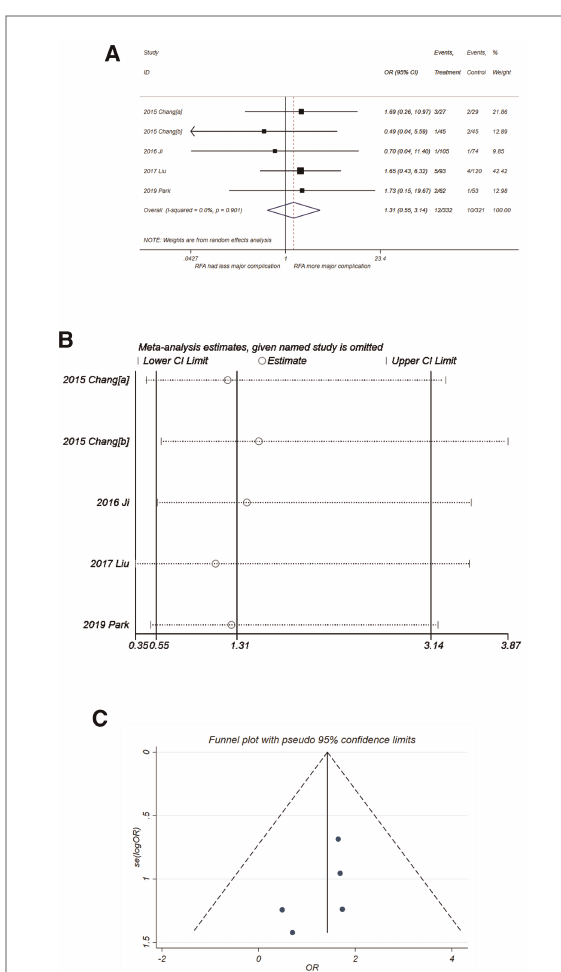
FIGURE 7 Comparison of major complication of RFA vs. PN. ( A ) The forest plot shows the OR of major complication of RFA vs. PN. OR>1 indicates that RFA has higher probability of major complication. ( B ) Sensitivity analysis was performed by omitting one study at each analysis. The result of each analysis is also presented as the forest plot. ( C ) The funnel plot was used to detect publication bias. PN, partial nephrectomy; RFA, radiofrequency ablation; OR, odds ratio.